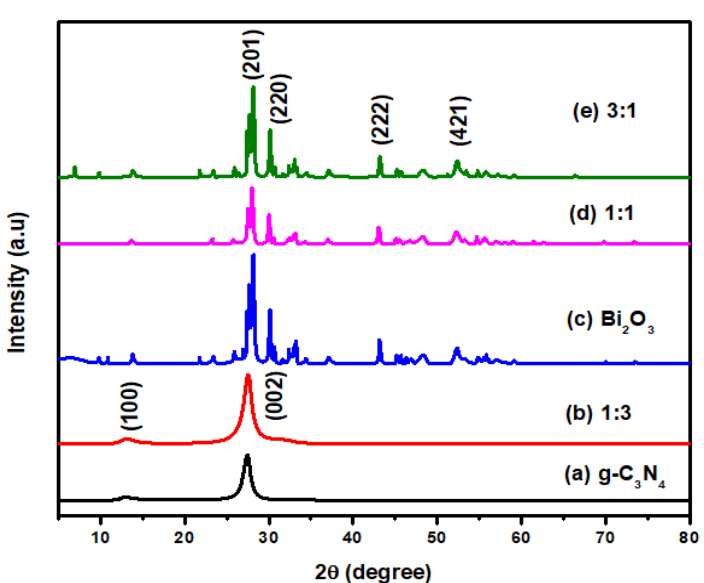
Figure 1. XRD pattern of ( a , c ) pristine g-C ₃ N ₄ and Bi ₂ O ₃ ; ( b , d , e ) different weight percentages of Bi ₂ O ₃ /g-C ₃ N ₄ nanocomposite. Morphology of the as-synthesized samples was examined by SEM analysis and is shown in Figure 2. The SEM image of g-C 3 N 4 describes that it has a stacked nanosheet structure and it is well matched with the literature [15]. The pure Bi 2 O 3 nanoparticle ex- hibits sub-micron level particle–like morphology and is shown in Figure 2b. The nano- composite shows the combination of nanosheets and nanoparticles, which reflects the presence of both g-C 3 N 4 nanosheets and Bi 2 O 3 nanoparticles. It can be clearly seen from the SEM analysis that the nanoparticles are deposited on the g-C 3 N 4 nanosheets. Further, the EDS analysis was performed on 1:1 nanocomposite to determine the elemental distri- bution and is shown in Figure 2. The EDS spectrum and elemental distribution micro- graphs show the presence of C, N, Bi and O in the nanocomposite. The EDS spectrum does not show any other peaks other than the above-mentioned elements, which indicates the purity of the prepared sample.